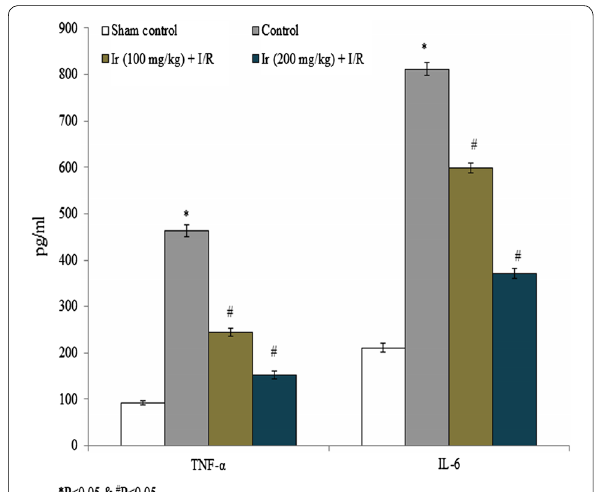
Fig. 7 Ir attenuated serum IL-6 and TNF-α level. Values are expressed as pg/mL. The results are expressed as control group, # P < 0.05 vs. treated